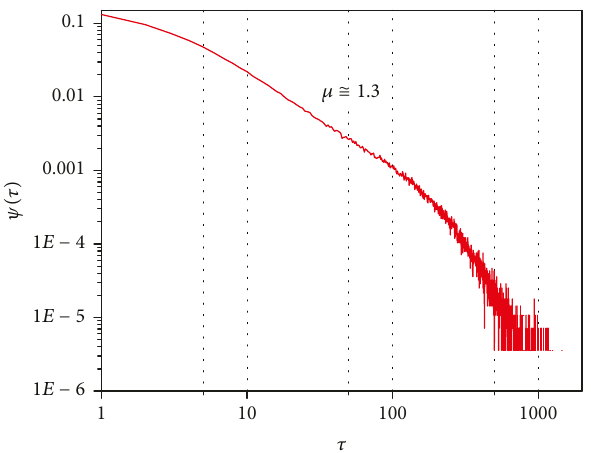
Figure 2: For bottom-up SOTC: the waiting-time PDF of the time interval between two consecutive crossings of the average value of the mean value of 𝐾(𝑡) , which is ≈ 1.5, is graphed. 𝜓(𝜏) is exponentially truncated and has an intermediate asymptotic regime with an index of 𝜇 ≈ 1.3 . This figure is similar to Figure 4 of